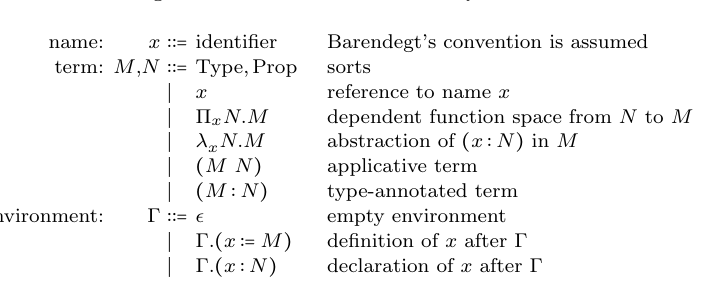
Fig. 10. Static corrections to the QE-GdA.